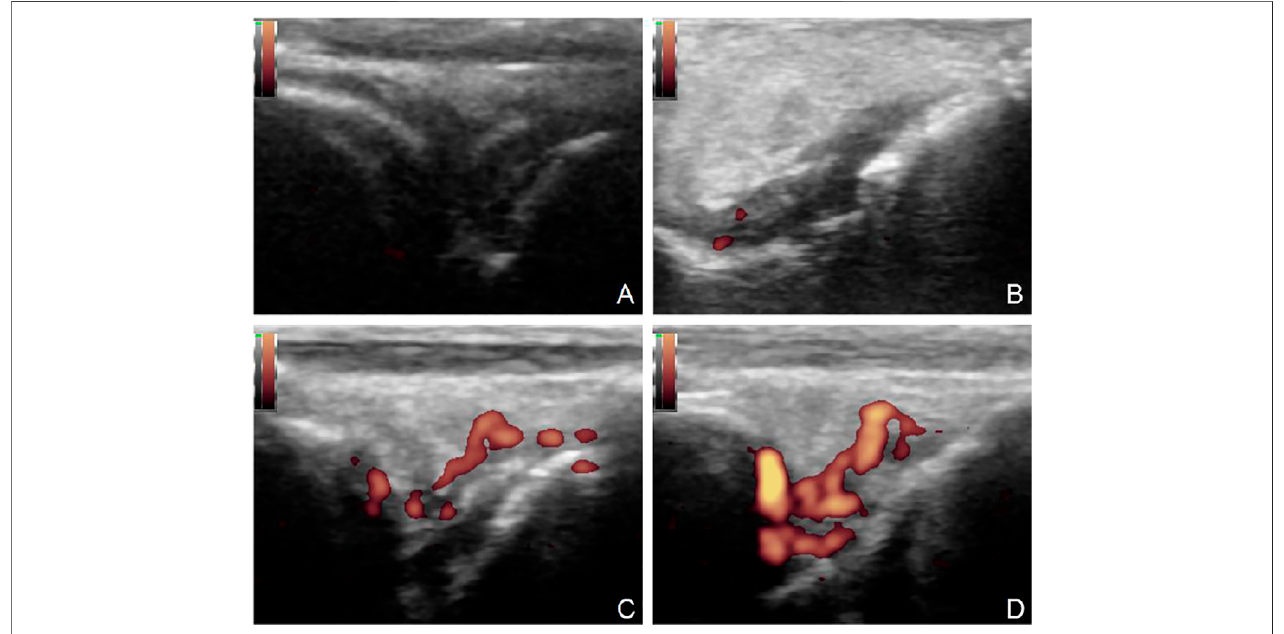
FIGURE 6 | Power Doppler ultrasound of synovitis. Score 0: no color blood fl ow signal (TP-SLN group, (A) . Score 1: dot color blood fl ow signals (TP group, (B) ). Score 2: short linear color blood fl ow signal with distribution less than 1/2 ofsynovial area (DMSO group, (C) ). Score 3: reticular blood fl ow signals distributed more than 1/2 of synovial area (control group, (D)